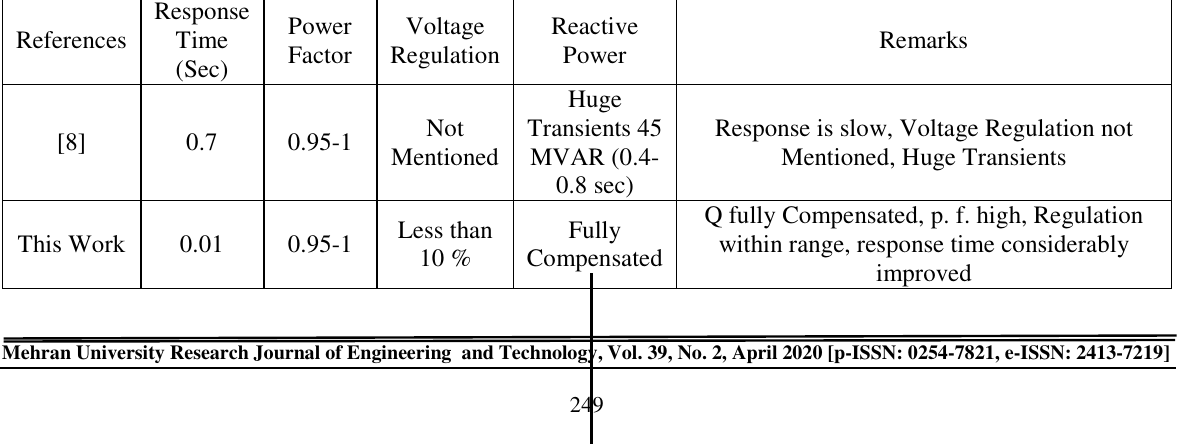
TABLE 1. COMPARISON BETWEEN TSC WITH TCR AND TSC WITH FIXED